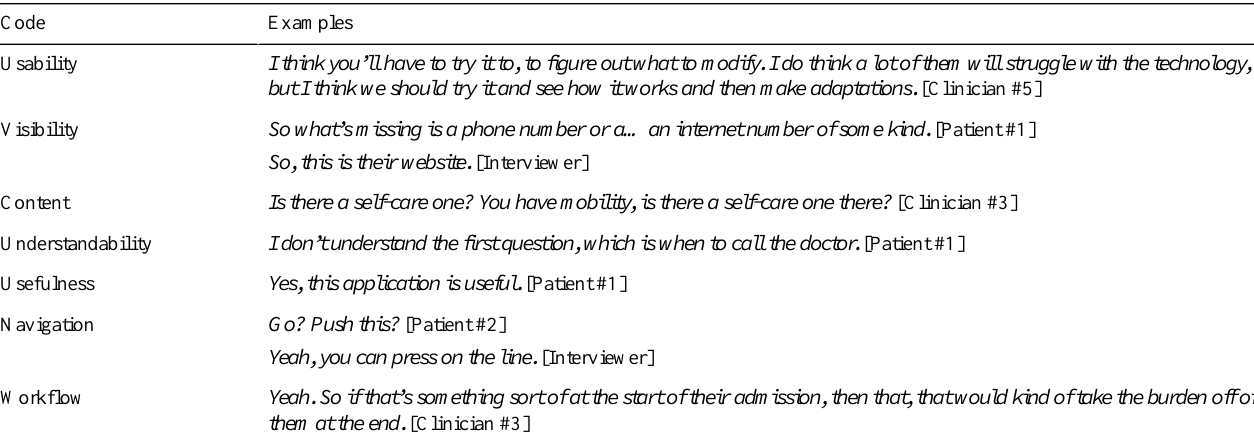
Table 2. Examples of quotes.